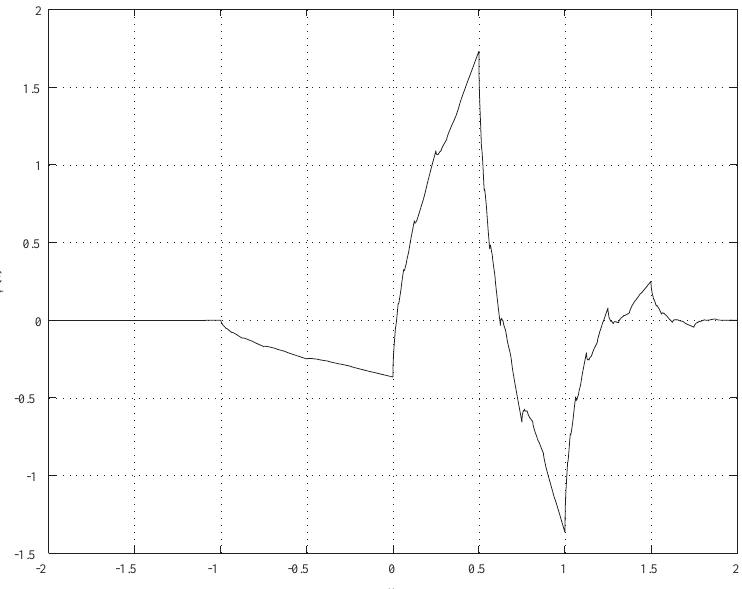
Figure 6. Daubechies wavelet (N =